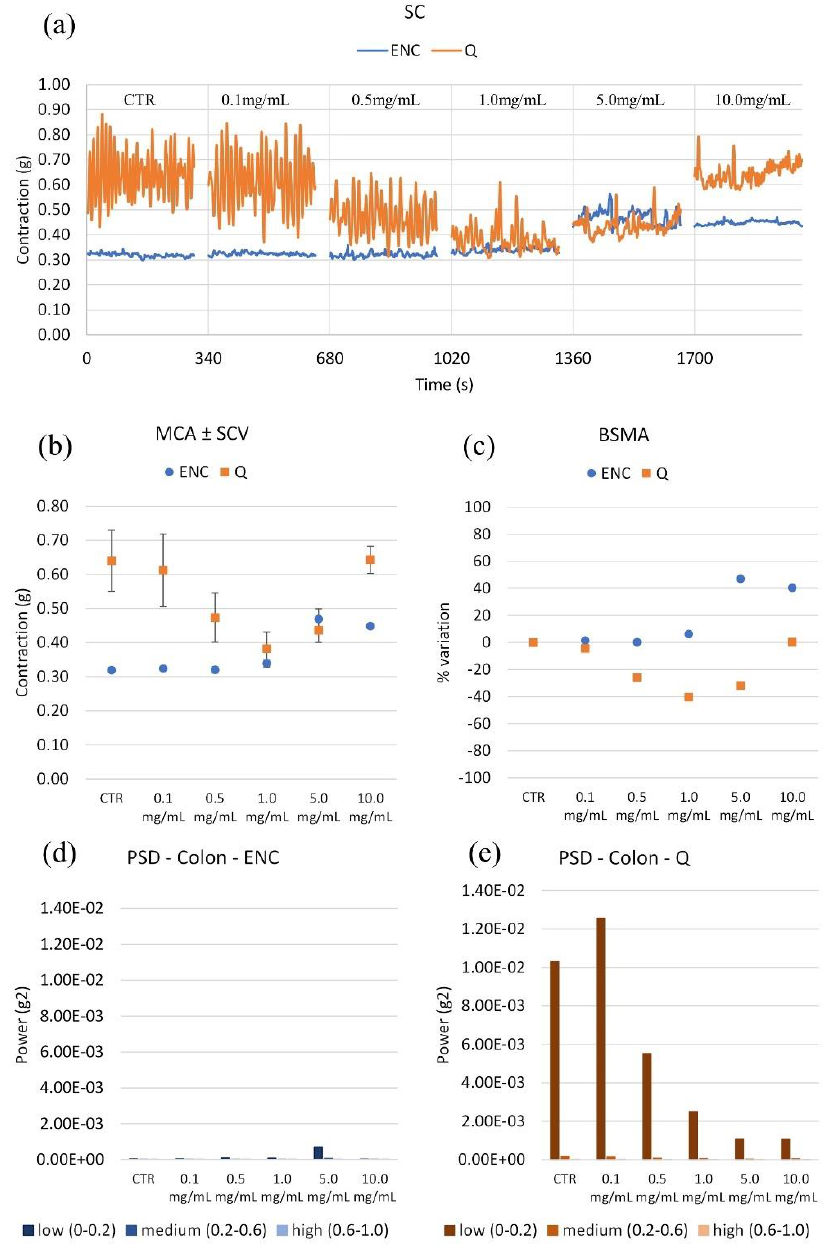
Figure 6. ( a ) Experimental original recording of the concentration–response curve of ENC ( Castanea sativa Mill.) and Q ( Schinopsis balansae Engl.) extract on colon spontaneous contractility (SC). ( b ) Mean contraction amplitude (MCA) with spontaneous contraction variability (SCV). ( c ) Basal Spontaneous Motor Activity (BSMA). Zero represents the basal tone, and each point is the percent variation from the baseline after cumulative addition of each dose; each value is the mean ± SEM; when the error bar is not shown, it is covered by the point. ( c ) Power Spectral Density (PSD): ( d ) Colon with ENC; ( e ) Colon with Q.